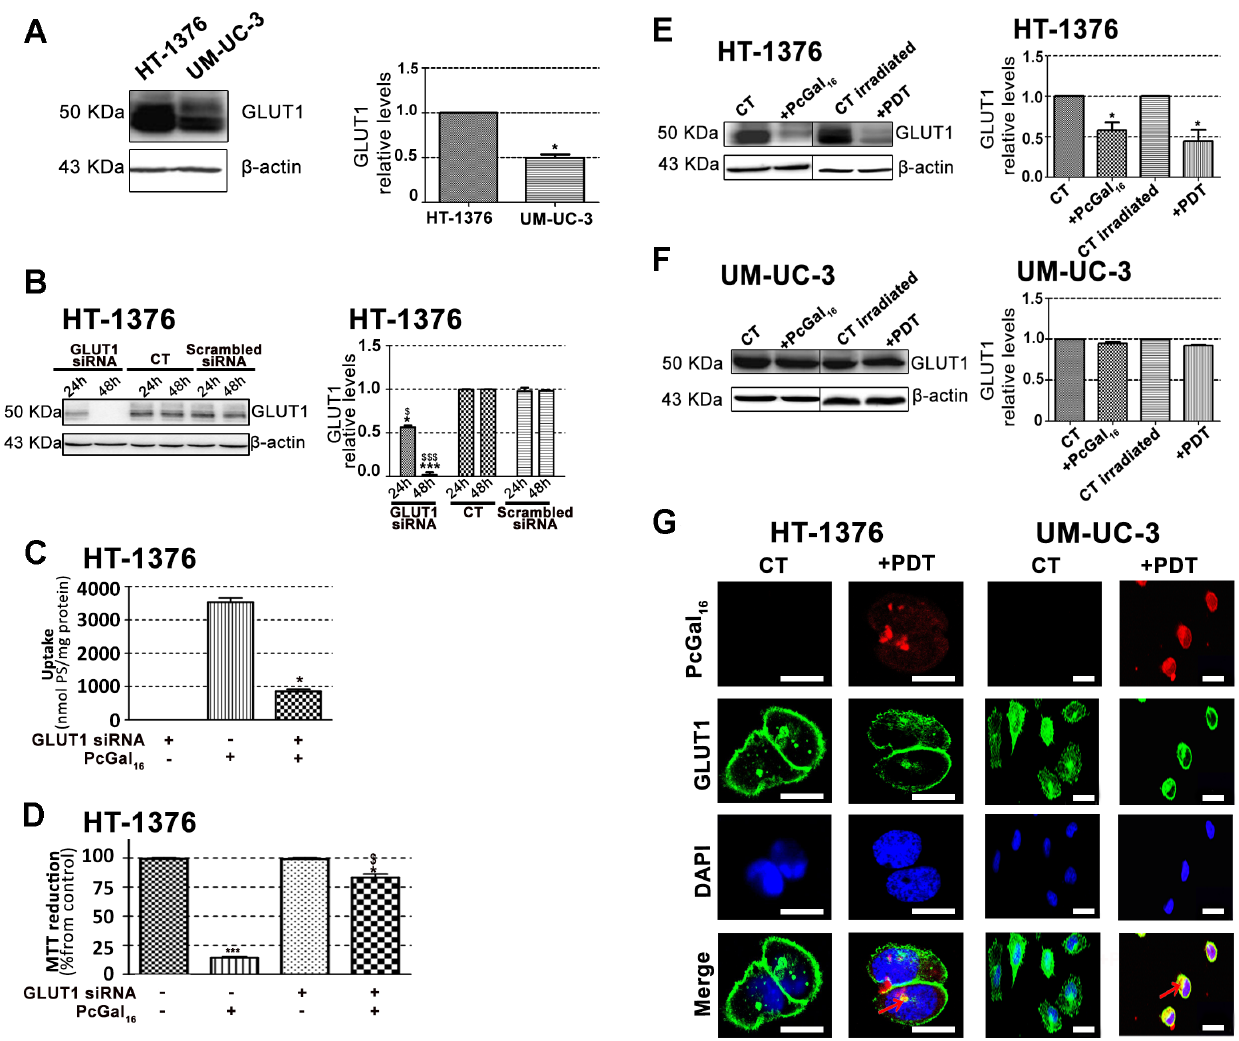
Figure 5. Knockdown of GLUT1 decreases de uptake and phototoxicity of PcGal 16 . Western blotting analysis and quantification of GLUT1 protein levels in HT-1376 and UM-UC-3 cells (panel A), in HT-1376 cells (panel E) or UM-UC-3 cells (panel F) after uptake with PcGal 16 in darkness and after PDT. b -actin was blotted as loading control. Quantitative analysis of GLUT1 (normalized to b -actin) expressed as a ratio of the levels found in HT- 1376 cells (panel A). *(p , 0.05) significantly different from HT-1376 cells. Quantitative analysis of GLUT1 (normalized to b -actin) expressed as a ratio of the levels found in untreated HT-1376 or UM-UC-3 cells (panel E, F). Data represents mean 6 S.D. of five independent experiments. *(p , 0.05) significantly different from untreated HT-1376 cells. Knockdown of GLUT1 in HT-1376 bladder cancer cells as determined by Western blotting 24 and 48 h post-transfection (panel B). Quantitative analysis of GLUT1 (normalized to b -actin) expressed as a ratio of the levels found in non-transfected control cells. Data represents mean 6 S.D. of five independent experiments. *(p , 0.05), ***(p , 0.0001) significantly different from non-transfected control cells. $ (p , 0.05), $$$ (p , 0.0001) significantly different from cells treated with scrambled siRNA. Intracellular uptake of PcGal 16 by HT-1376 bladder cancer cells transfected with GLUT1 siRNA (panel C). The cells were incubated with PcGal 16 24 h post-transfection. Data are the mean 6 S.D. of at least three independent experiments performed in triplicates. *(p , 0.05) significantly different from non-transfected control cells. Photocytotoxic effects after PcGal 16 -PDT in UM-UC-3 cells transfected with galectin-1 siRNA (panel D). Phototoxicity was evaluated 72 h after PDT. Data are the mean 6 S.D. of at least three independent experiments performed in triplicates. *(p , 0.05), ***(p , 0.0001) significantly different from control cells. *(p , 0.05), significantly different from PDT with PcGal 16 in non-transfected cells. Representative fluorescence images (panel G) of GLUT1 protein (green) in HT-1376 and UM-UC-3 cells before and after incubation with PcGal 16 (red), with DAPI staining the nucleus (blue). Scale bars 20 m m.